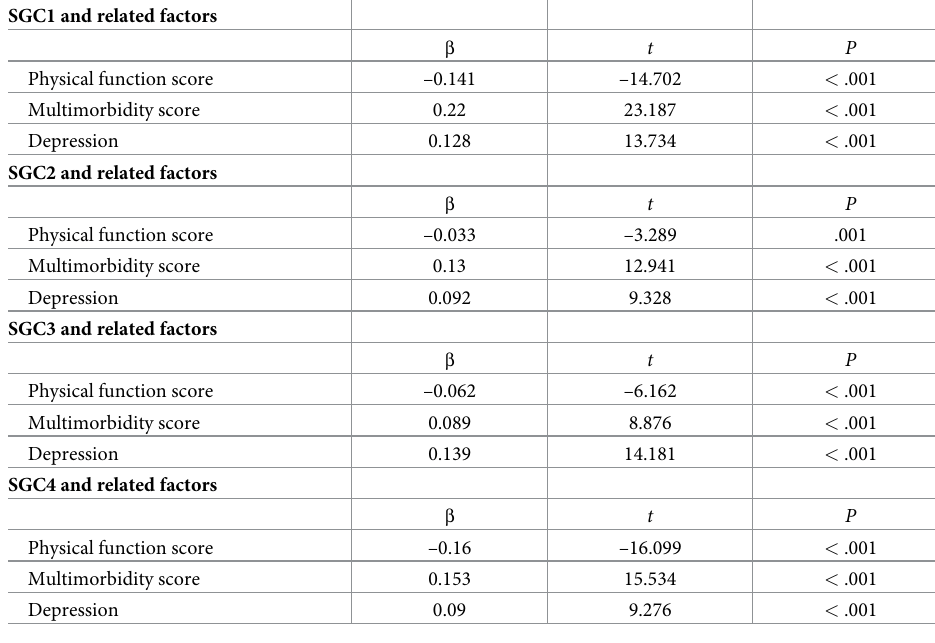
Table 4. Association between each SGC component and other